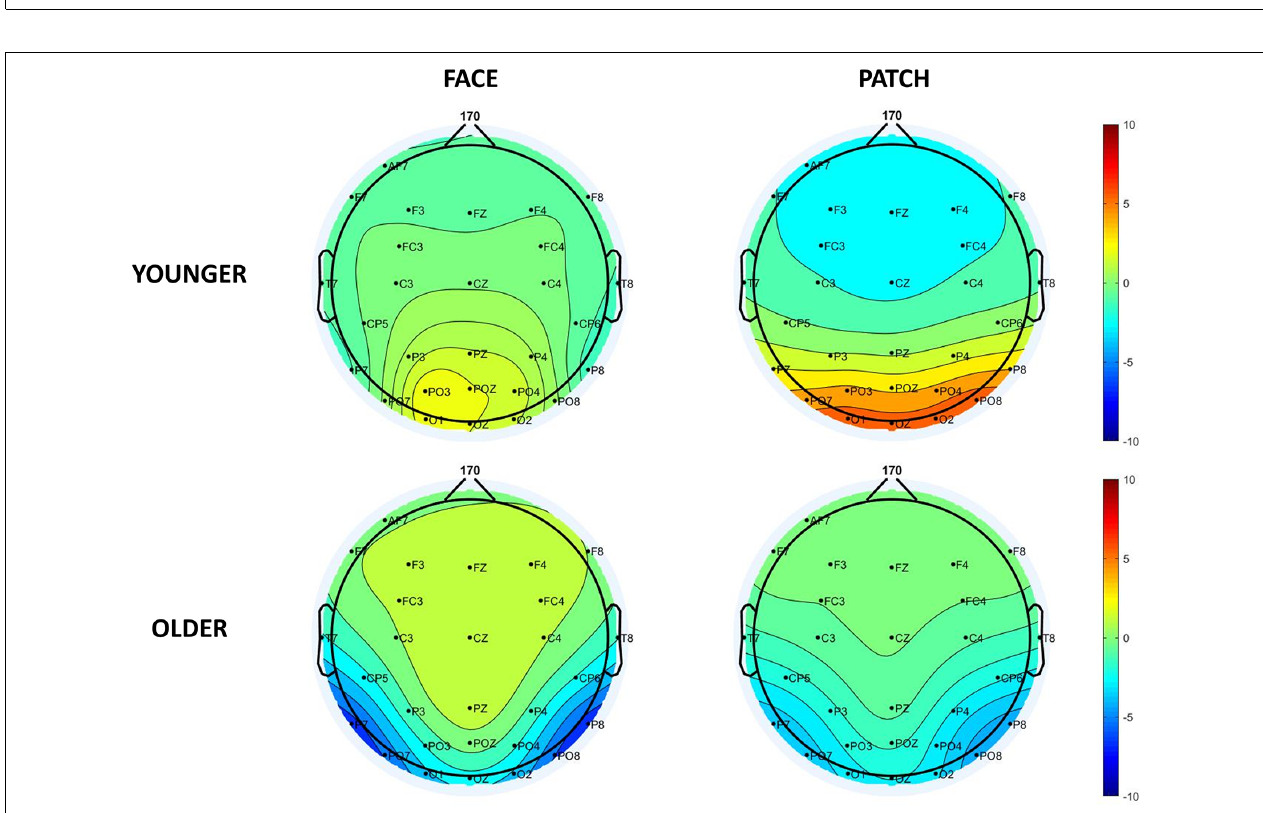
FIGURE 3 | Scalp distribution of the N170 component for faces (left side) and patches (right side) in younger (top panel) and older adults (bottom panel).